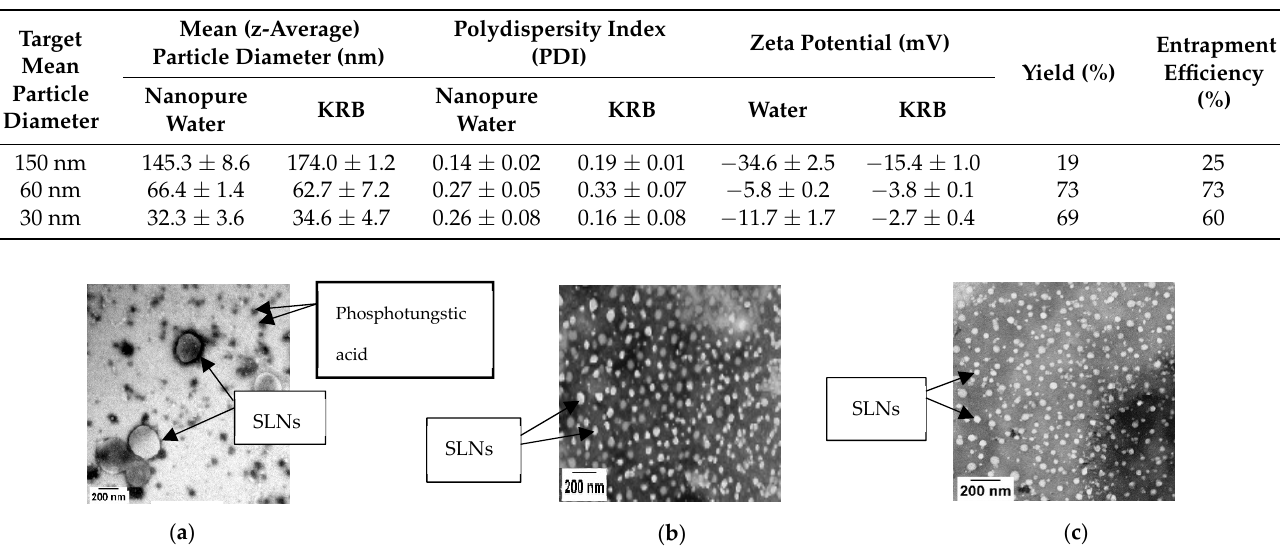
Figure 1. Transmission electron micrographs of 150 nm ( a ), 60 nm ( b ), and 30 nm ( c ) SLNs. The nanoparticles were negatively stained with 2% phosphotungstic acid. A JEOL JEM-1230 TEM (JEOL, Peabody, MA, USA) was used to obtain the images.